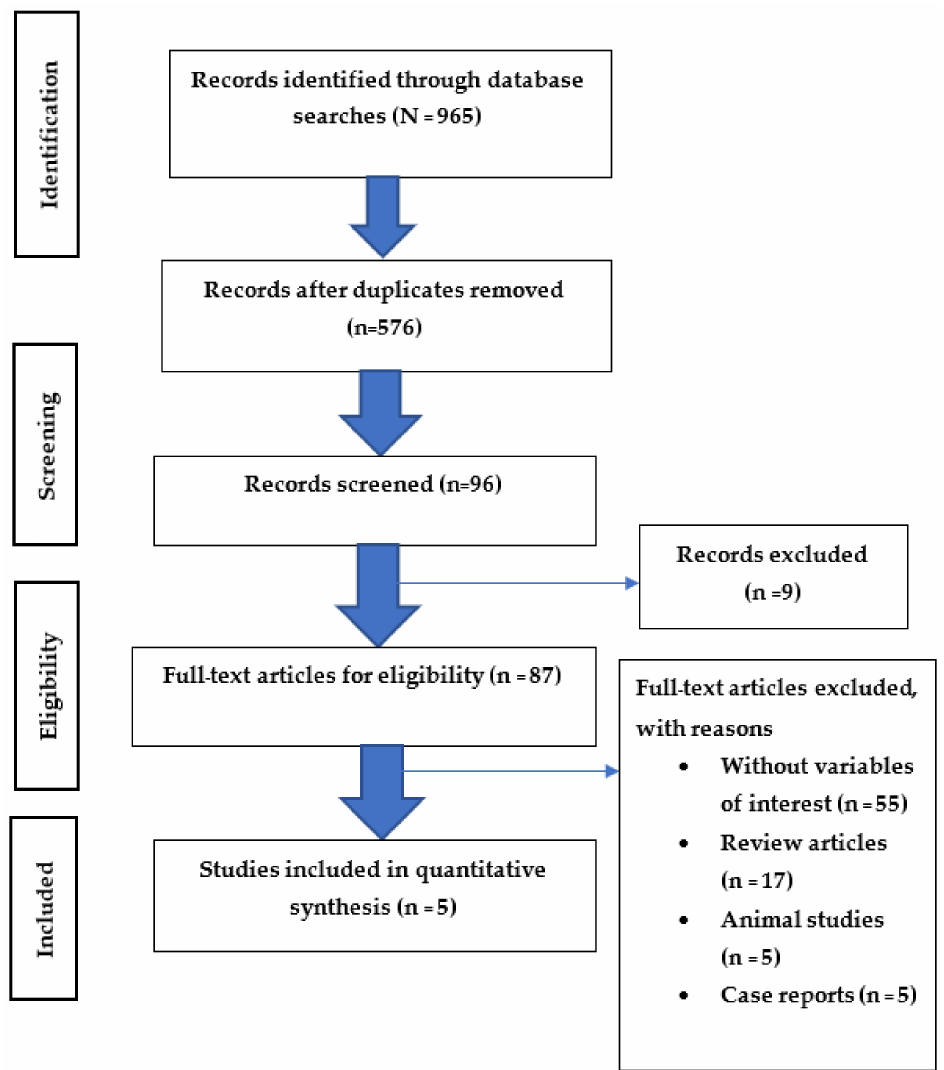
Figure 1. Flow chart of the study selection process (PRISMA). N = records identified through database searches, n = records after database